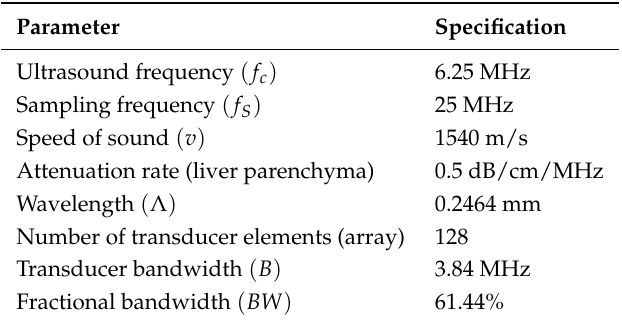
Table 1. Main parameters used in the ultrasonic imaging